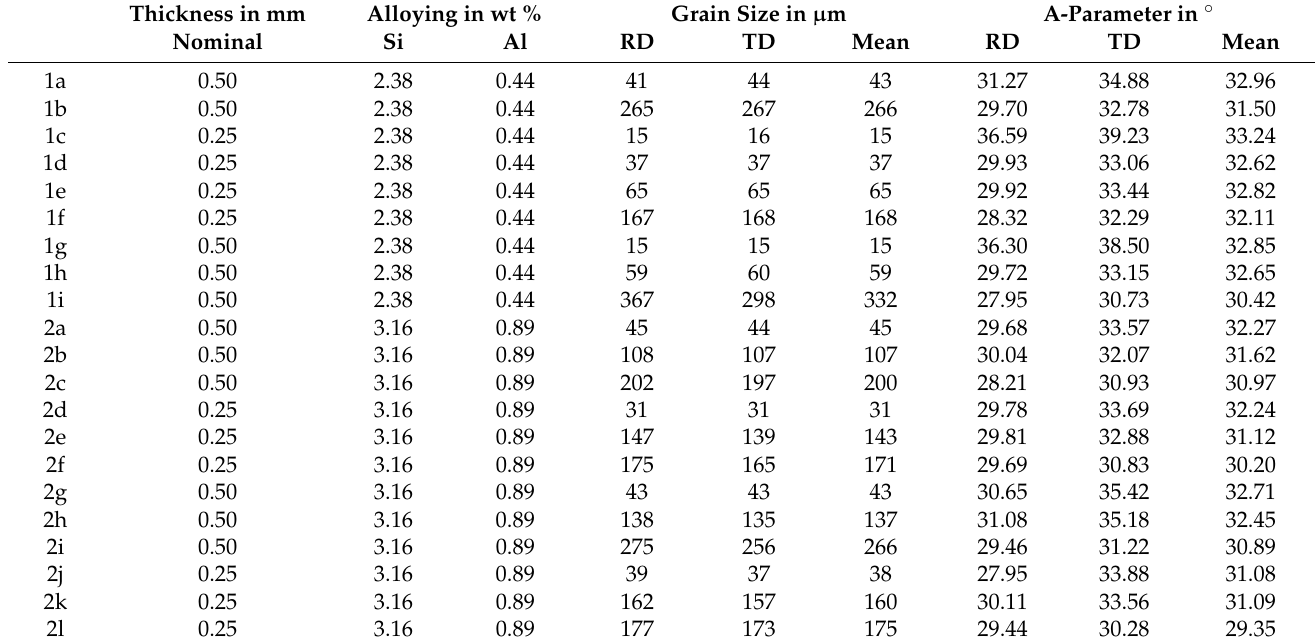
Table 4. Material parameters for the studied experimental steel